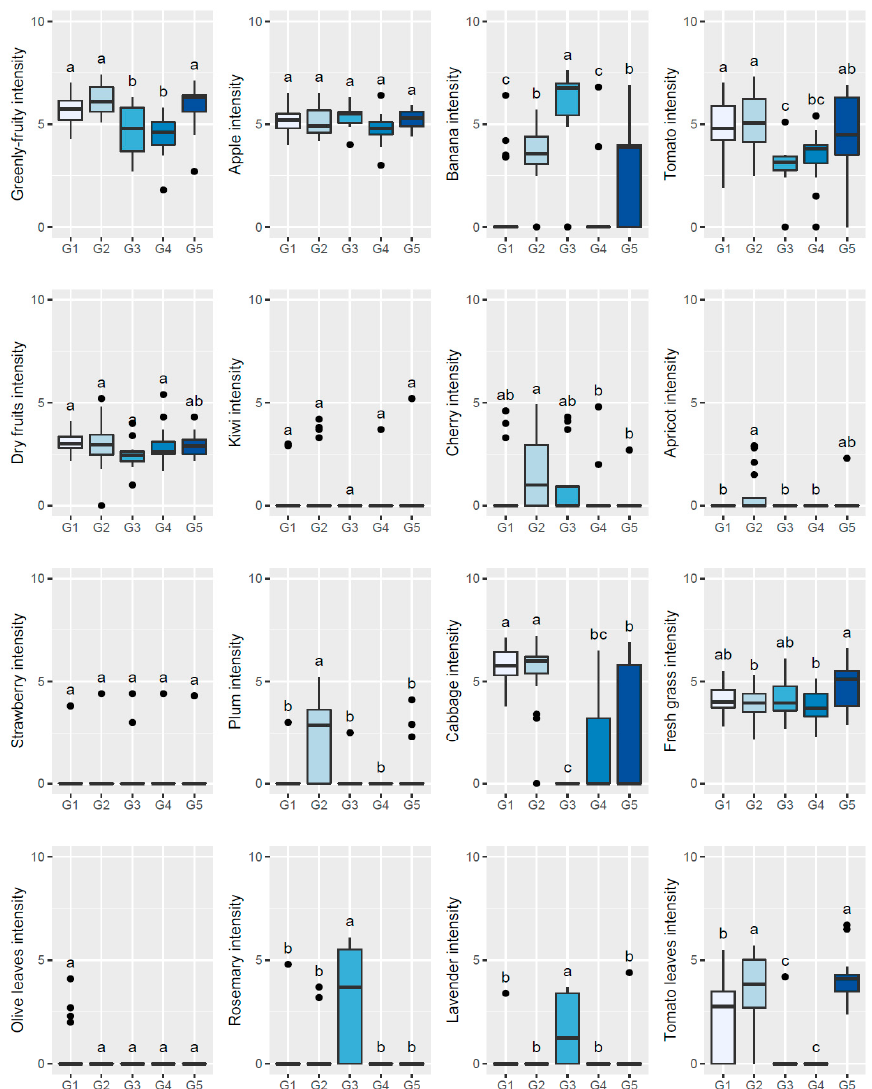
Figure 4. Sensory profile boxplots (gustatory sensations) found in olive oils extracted from olives from centenarian olive trees in the Côa Valley region. Different lowercase letters signify statistically significant differences at a 5% significance level (one-way ANOVA followed by Tukey’s multiple comparison test).